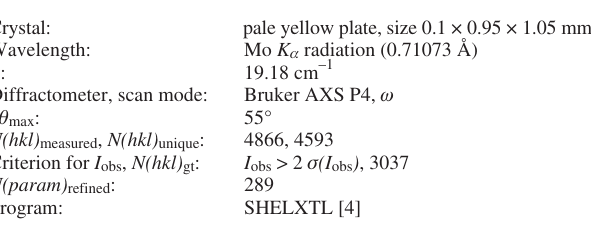
Table 1. Data collection and handling.